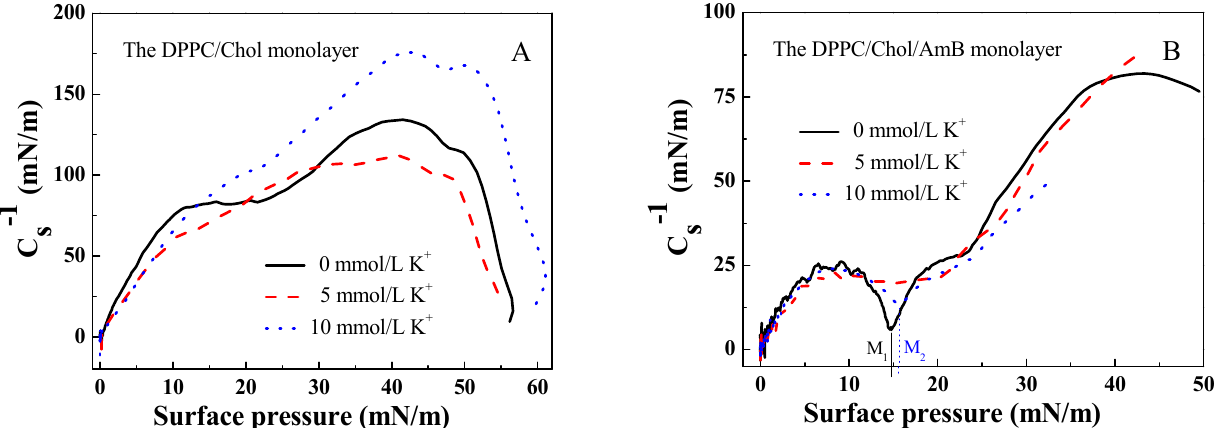
Figure 2. The elastic modulus–surface pressure ( C − 1 s - π ) curves of ( A ). the DPPC/Chol mixed monolayer and ( B ). the DPPC/Chol/AmB mixed monolayer at the air–water interface in the absence and presence of potassium ions (5 mmol/L and 10 mmol/L).